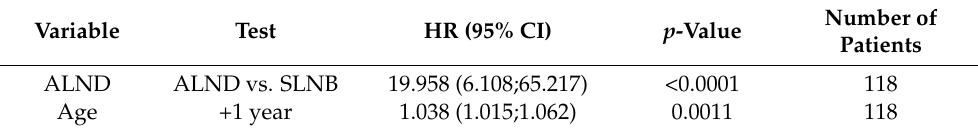
Table 4. Multivariate analysis of